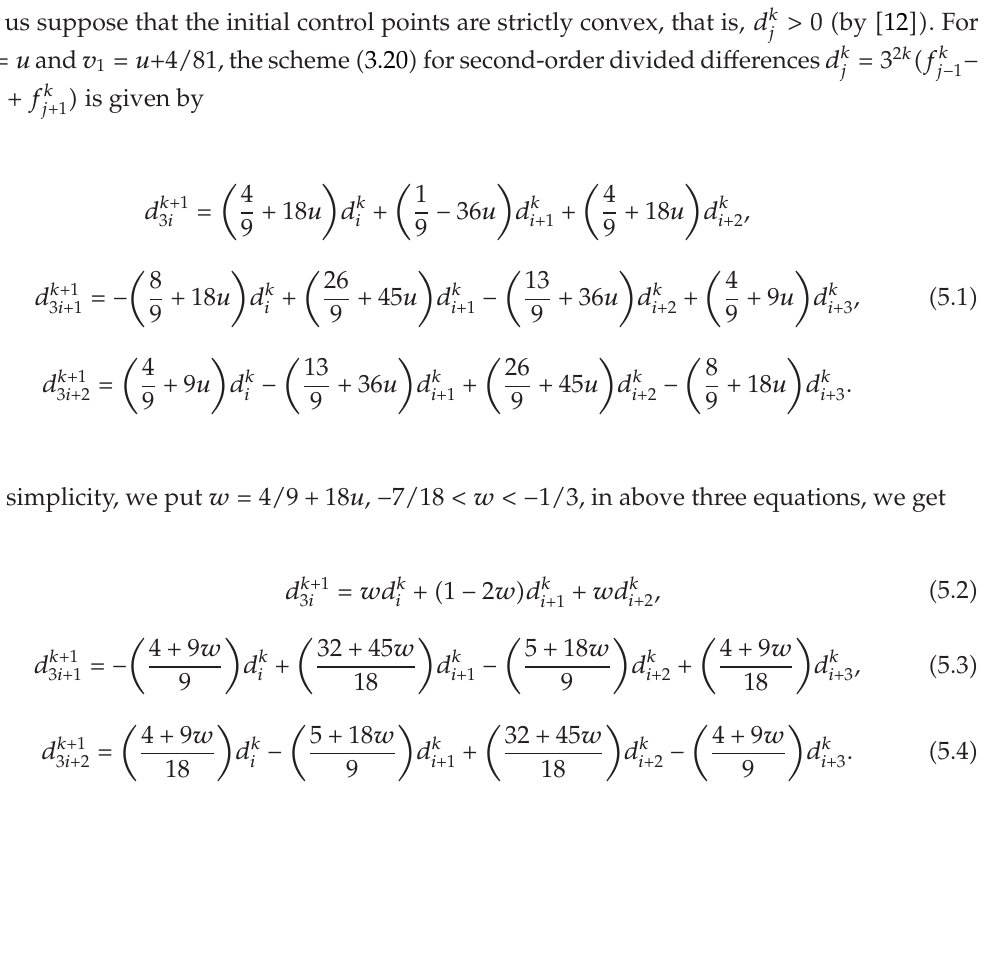
scheme (cid:2) 3.20 (cid:4) . Convexity of other schemes can be discussed analogously. We adopt the same procedure as described by (cid:8) 11 (cid:9)